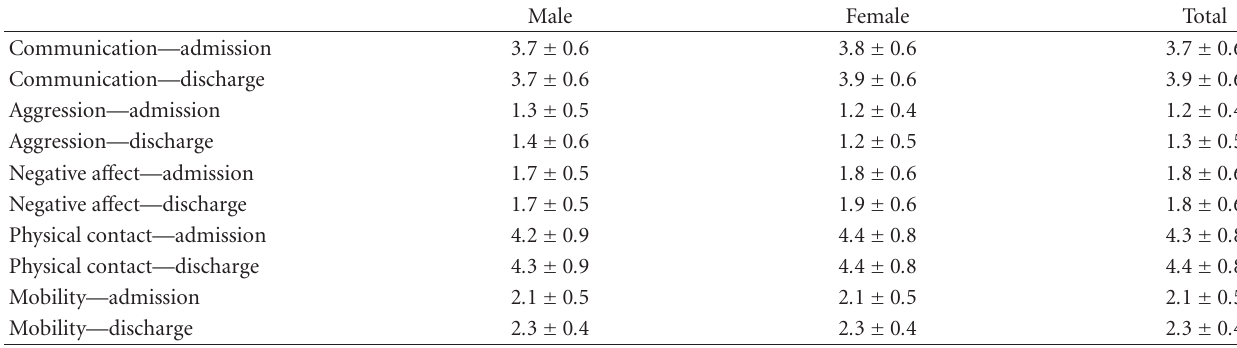
Table 2: Means scores of QoL scores from both assessments by gender.